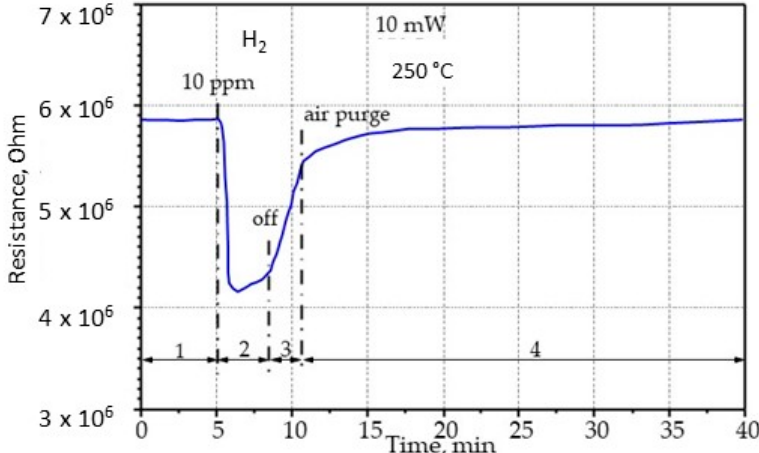
Figure 10. Chemical response of the thin-film sensor on an AA membrane to 10 ppm hydrogen at a temperature of 250 °C.